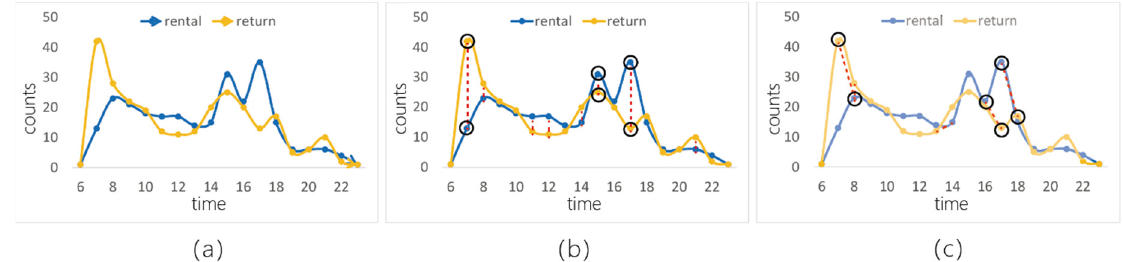
Figure 4. A sample of ( a ) time-varying feature, ( b ) similarity feature, and ( c ) lead–lag relationship feature for PB hourly checkout and